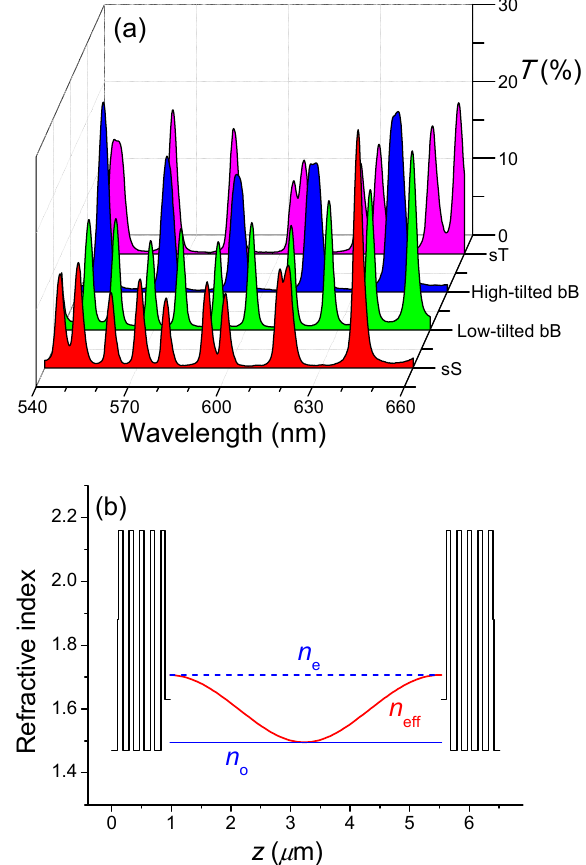
Figure 2. ( a ) Transmission spectra of the 1D PC/CD-DFLC cell in four different states; and ( b ) spatial distributions of the ordinary refractive index n o , the extraordinary refractive index n e , and the effective (cid:113) n 2 e sin 2 ( φ ) + n 2 o cos 2 ( φ ) , where φ is the azimuthal angle of director refractive index n eff =